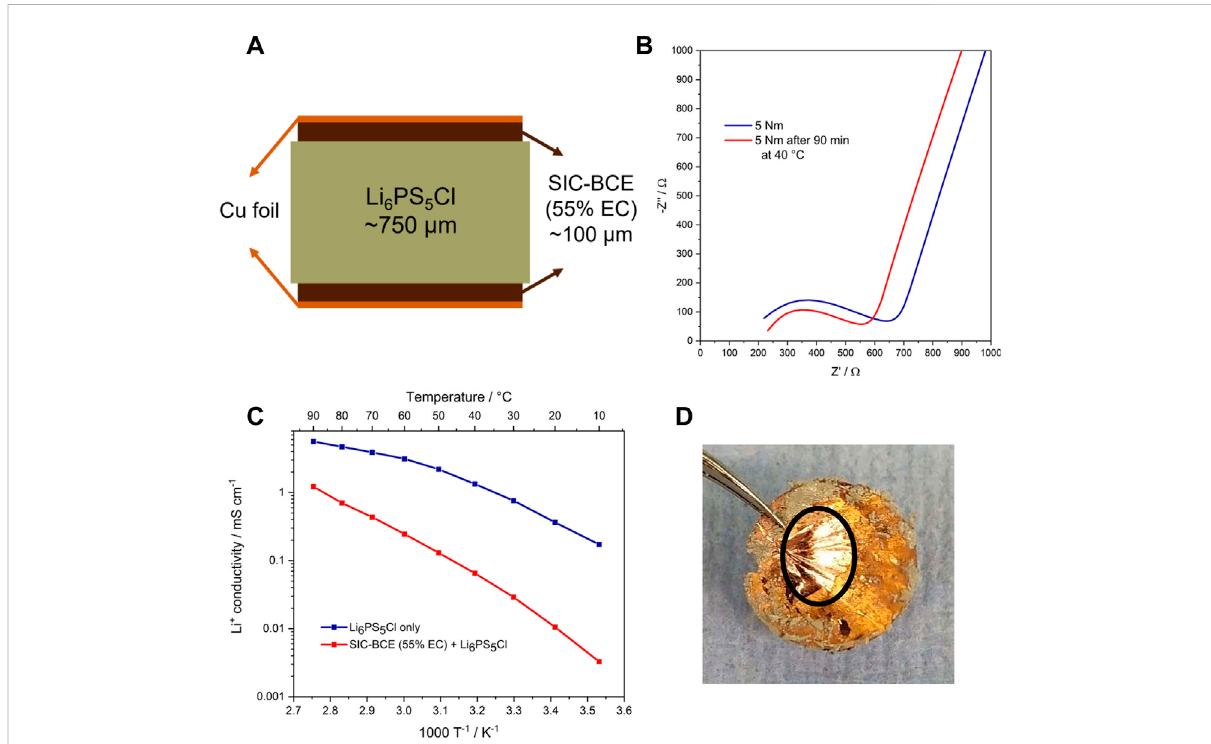
FIGURE 4 (A) Scheme of the cell setup used for the conductivity measurements of the SIC-BCE as interlayer between the copper current collector and solid-state thiophosphate electrolyte. (B) Nyquist plots of the impedance data obtained right after applying pressure to the cell and after 90 min storage at 40 ° C. (C) Comparison ofthe ionic conductivity of pure thiophosphate pellets (blue) and thelayeredhybrid system with thethiophosphate pellet sandwiched between to SIC-BCE membranes on copper foil (red). (D) Photograph of the copper foil after the conductivity tests with some residual thiophosphate (greenish residues). The part outside the black circle was still covered by the SIC-BCE membranes, while it had been removed for the part within the black circle, revealing a shiny copper